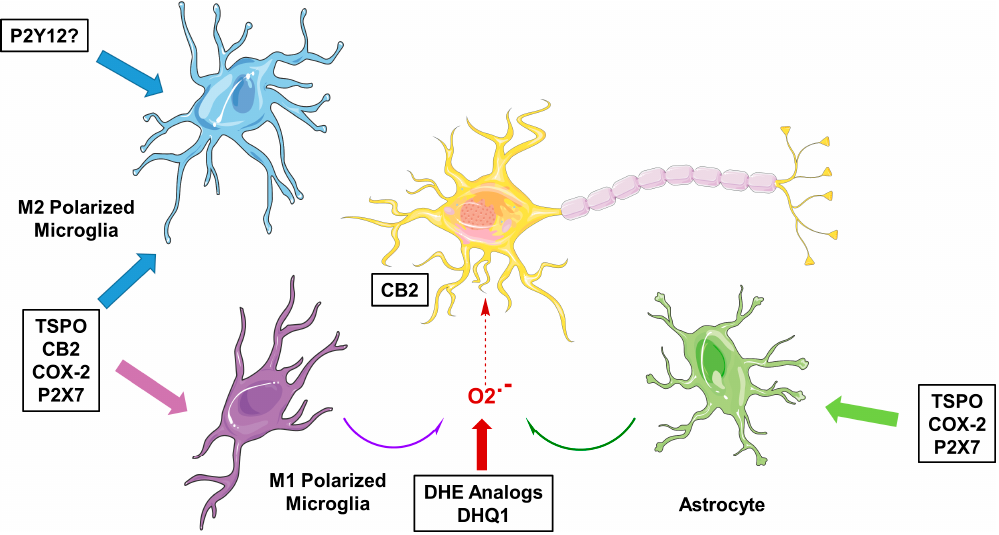
Figure 1. Molecular targets for imaging neuroinflammation in neurodegeneration. TSPO = translocator protein 18 kDa; CB2 = cannabinoid receptor type 2; COX-2 = cyclooxygenase-2; DHE = dihydroethidium; DHQ1 = dihydroquinoline analog.